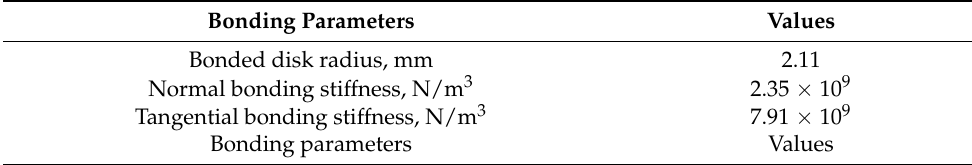
Figure 4. DEM model of rice grain ( a ) and flexible rice straw ( b ). Table 3. Bonding parameters of the flexible rice straw [6].